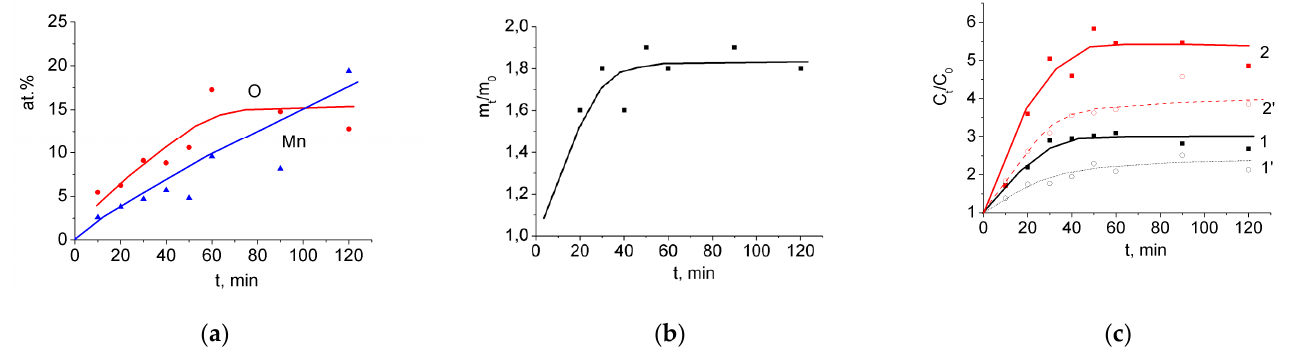
Figure 7. ( a ) Concentrations of Mn and O, at.%; ( b ) weight increase, mt/m0; ( c ) increase in the spe- cific capacitance, C t /C 0 : 1- Cspm , 2- Csps ; curves 1’ and 2’ show the growth relative to the oxidized capacitance, C t /C 0 : 1- C spm , 2- C sps ; curves 1’ and 2’ show the growth relative to the oxidized sample.